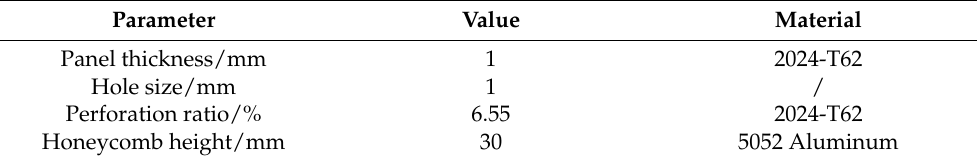
Figure 11. Test piece of “ split acoustic liner ” . Table 3. Structure parameters of “ split acoustic liner ” .